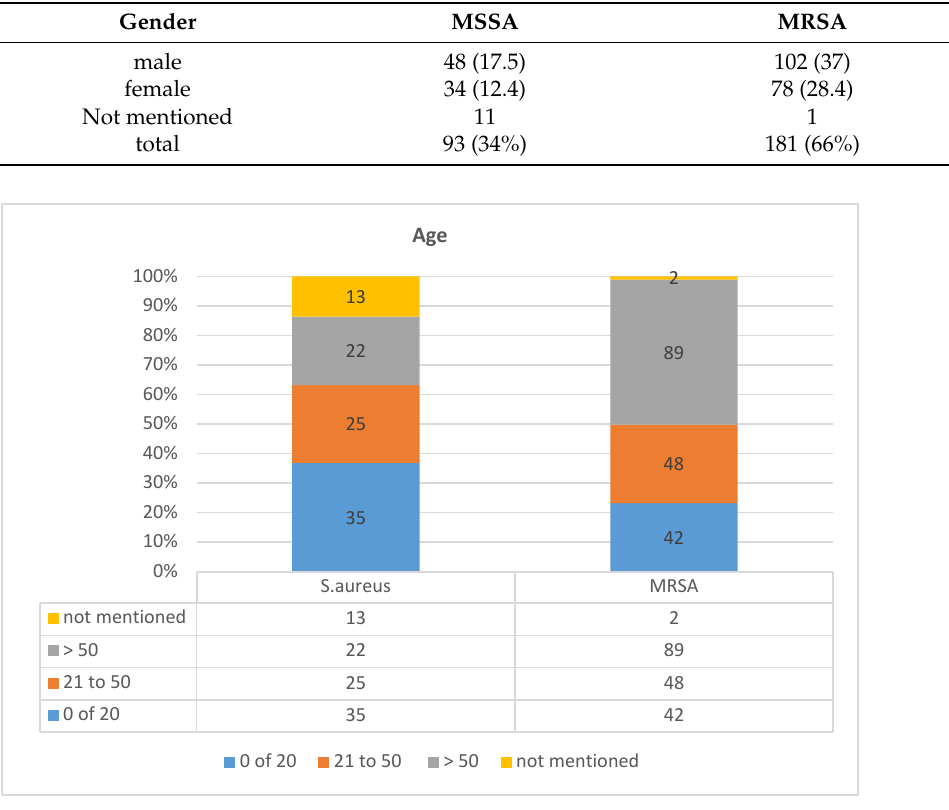
Figure 4. Age-specific distributions of methicillin-resistant and susceptible Staphylococcus aureus lineages in Ha’il region, Saudi Arabia.